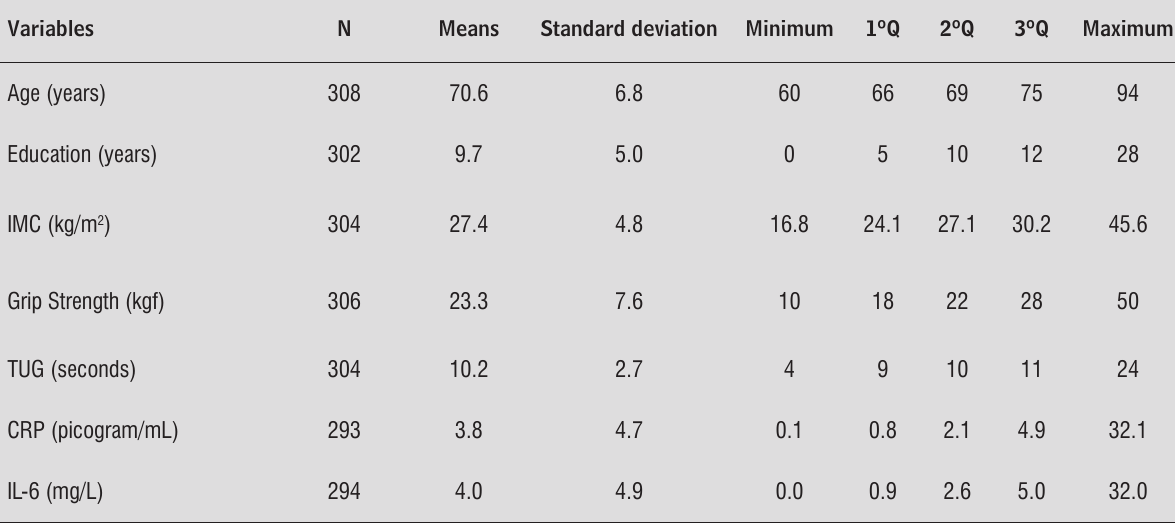
Table 2 - Means and quantitative